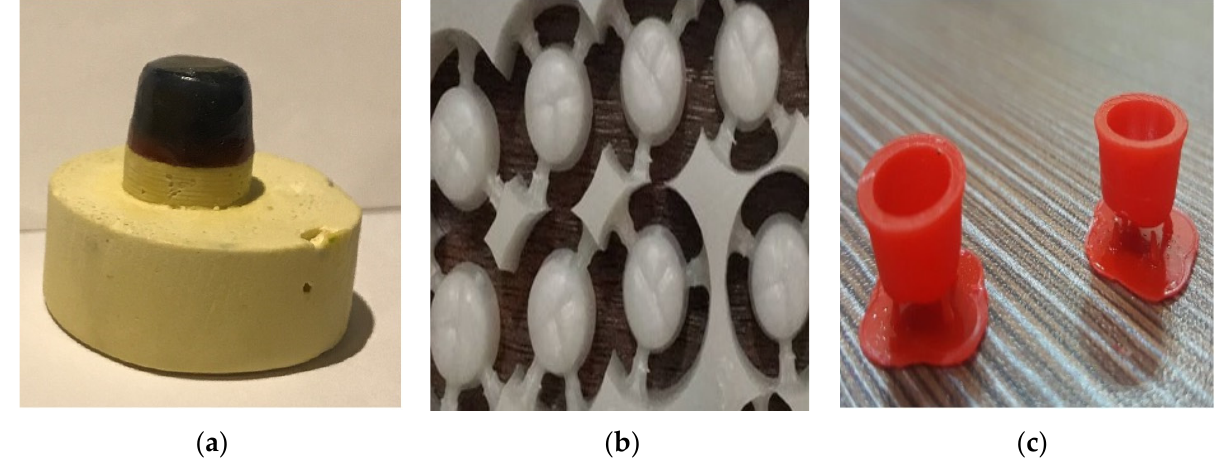
Figure 3. Three different types of wax patterns; conventional ( a ), Milled ( b ) and 3D ‐ printed ( c ). Group 2 ‐ CAD/CAM by milling: